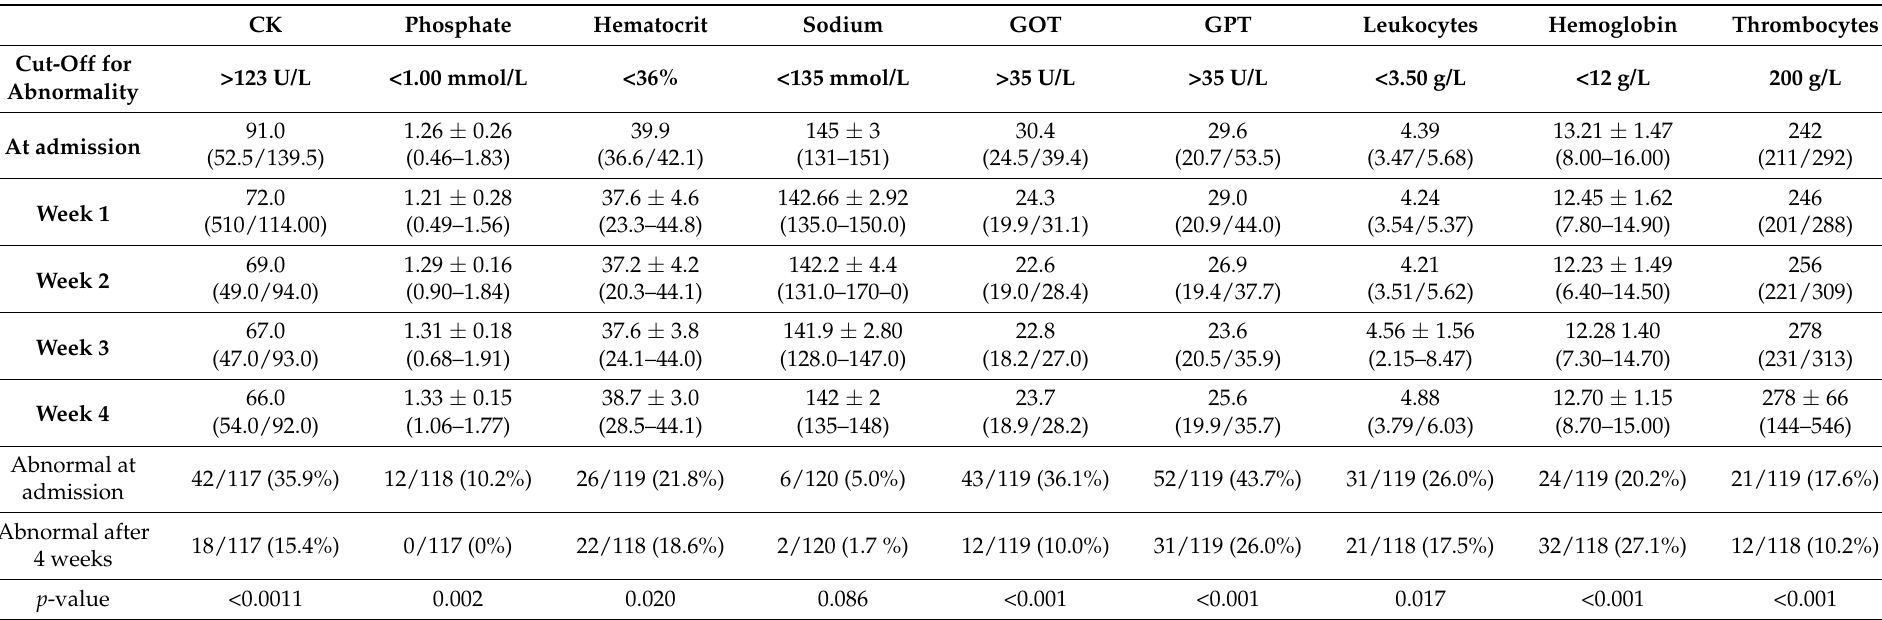
Table 5. Laboratory values on admission and by week four and percentage of pathological